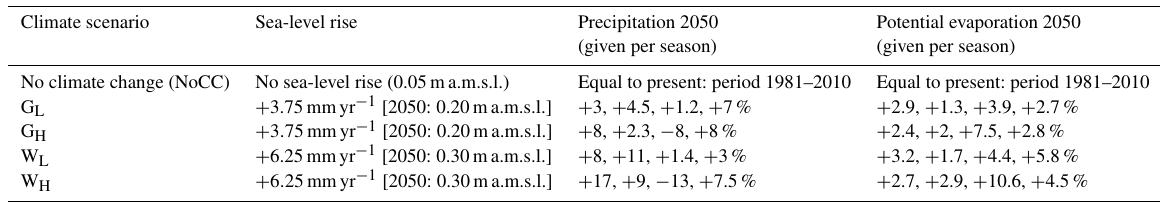
Table 3. Model climate change scenarios for the period 2011–2050, with two rates of SLR, starting at 0.05ma.m.s.l. and seasonal variation in groundwater recharge (DJF, MAM, JJA,